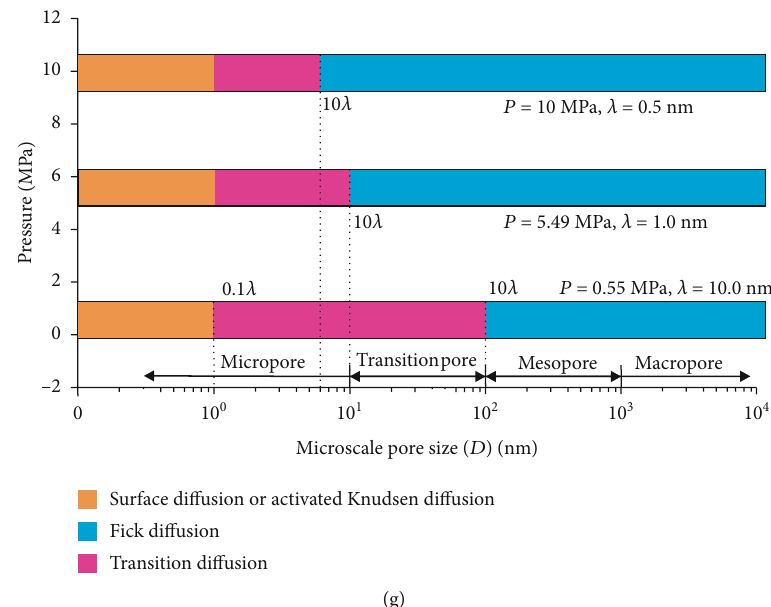
Figure 19: Characterization of the pore-fracture structure in di ff erent coals: (a, b) pore size distribution of coals from the gas adsorption/desorption method; (c, d) pore volume and SSA of coals; (e, f) pore size distribution of coals from the MIP method; (g) relationship between the gas di ff usion mechanism and pore size (modi fi ed from Du et al. [81] and Wang et al.